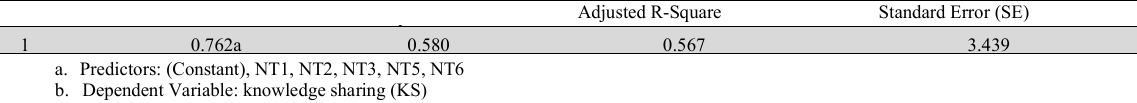
Summary regression